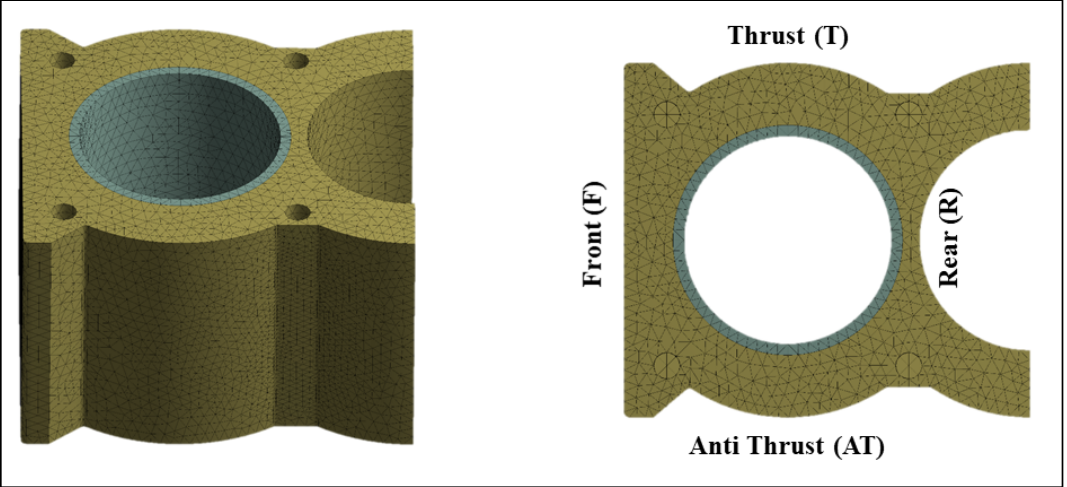
Figure 1. One and half cylinder model used in this study with the di ff erent sides of the